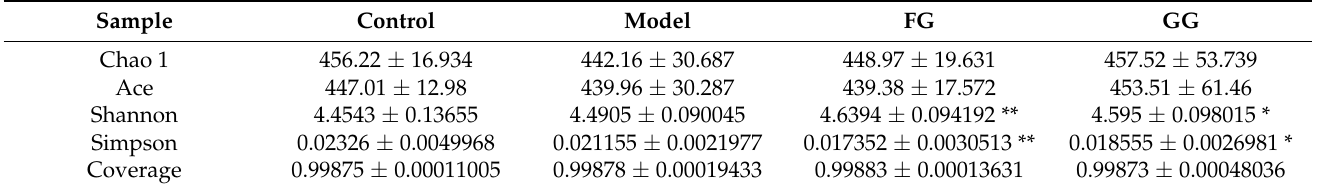
Table 3. Alpha diversity index